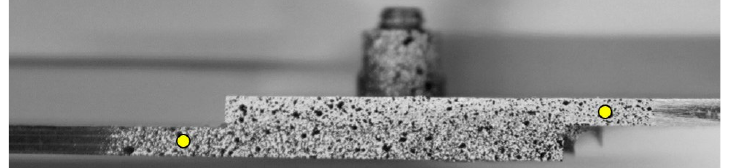
Figure 6. Example of a bonded/bolted specimen (overlap length: 26 mm and height: 4.55 mm) with a speckle pattern; the tracked points are shown in yellow and the displacement reported for each specimen was the magnitude of the vector between the points.